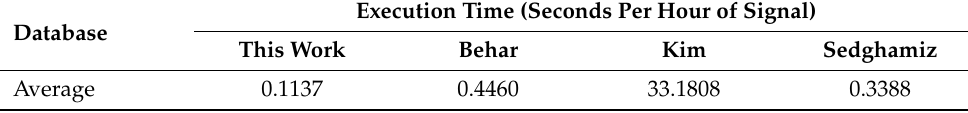
Table 4. QRS detection execution